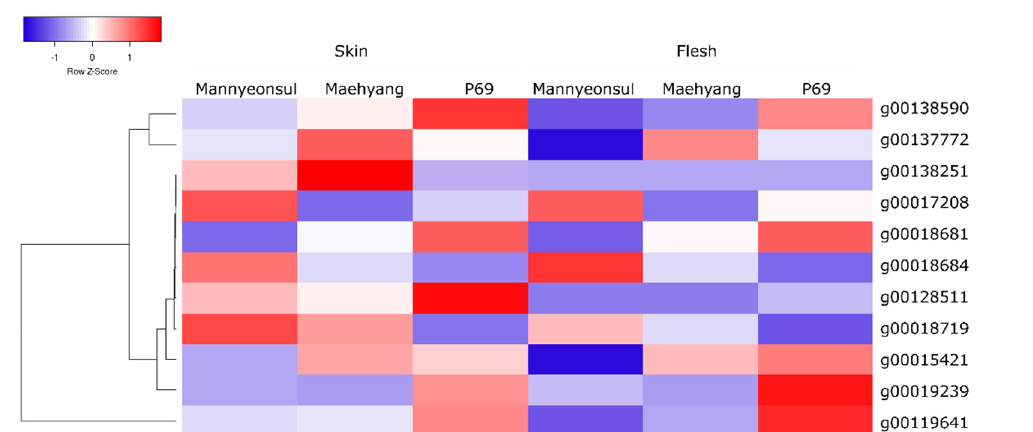
Figure 6. Heat map representation of 11 differentially expressed predicted candidate genes (fold-change > 2 and FDR < 0.05) associated with fruit color in three cultivars of strawberry. Table 3. Predicted candidate genes in QTLs associated with the fruit color in the ‘BS F 2 (II)’ popula- tion.